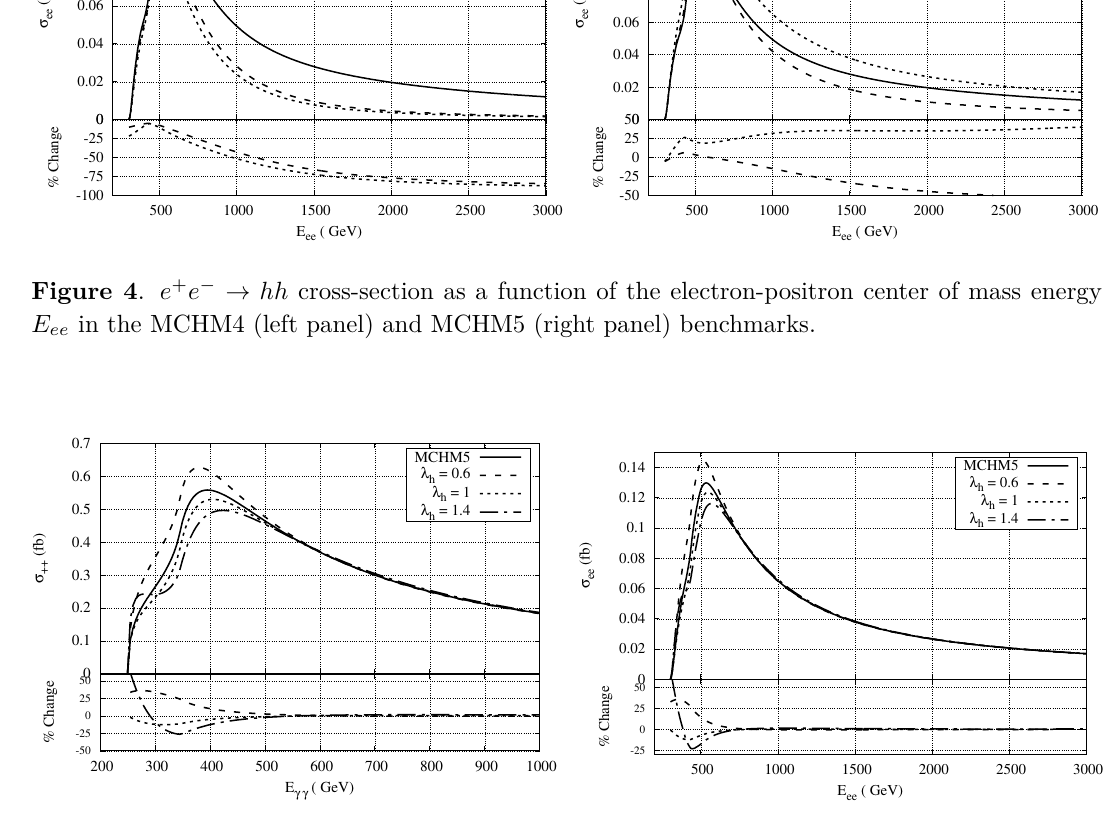
Figure 5 . γγ → hh cross-section for same photon helicity (left panel) and e + e − → hh cross-section (right panel) in MCHM5-Higgs, compared to the MCHM5 benchmark. Here we fix ξ = 0 . 1 . The percentage change in above plots represents change when the value of trilinear Higgs coupling is taken as an independent parameter as compared to the MCHM5 values for ξ = 0 . 1